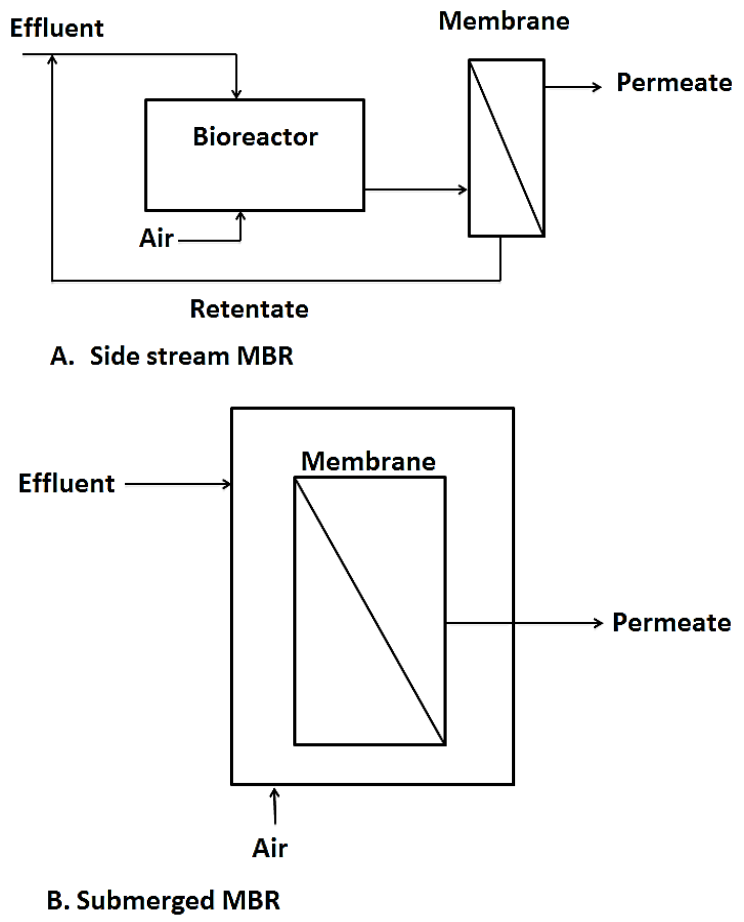
Figure 6. The two types of MBR, diagram taken from [92] .